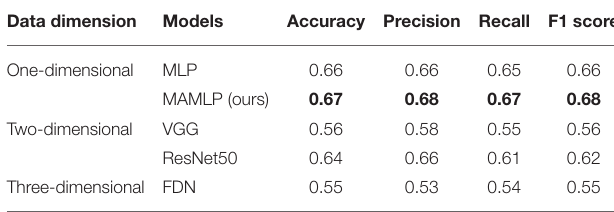
TABLE 4 | Data summary of different methods based on different data